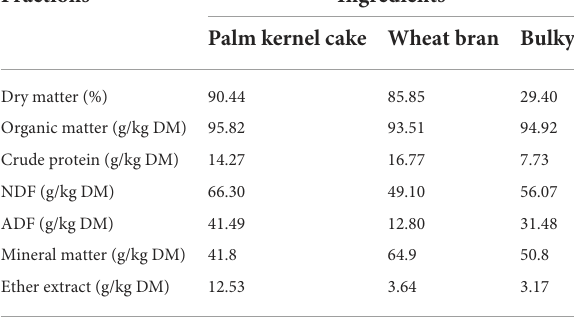
TABLE 1 Chemical composition of the ingredients of the experimental diets.